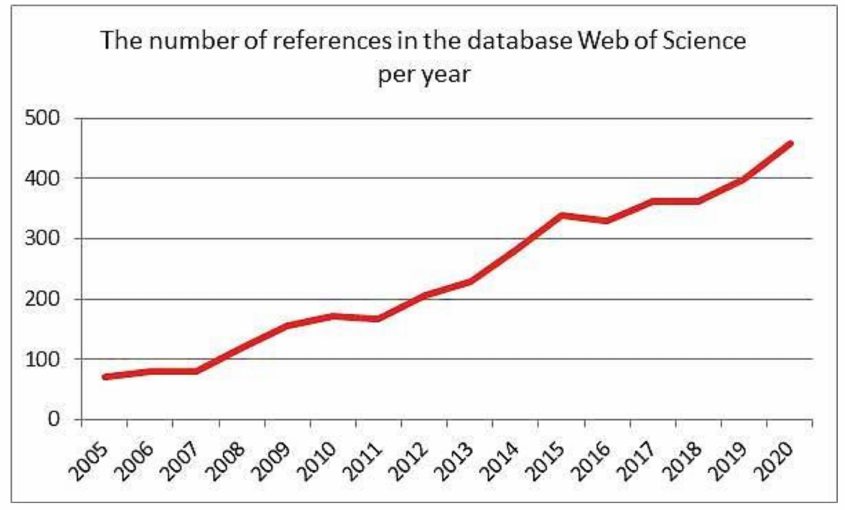
Figure 4. Web of science references research results on “salt reduction” and “food” key words